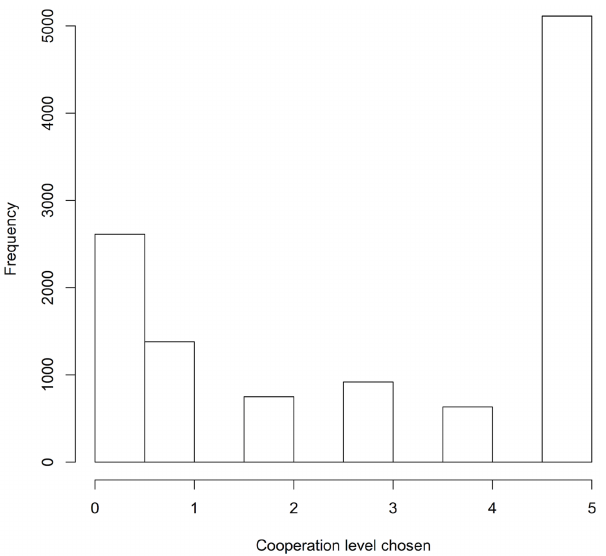
Fig 1. Histogram of cooperation levels chosen by players. Data exclude rounds where either player opted